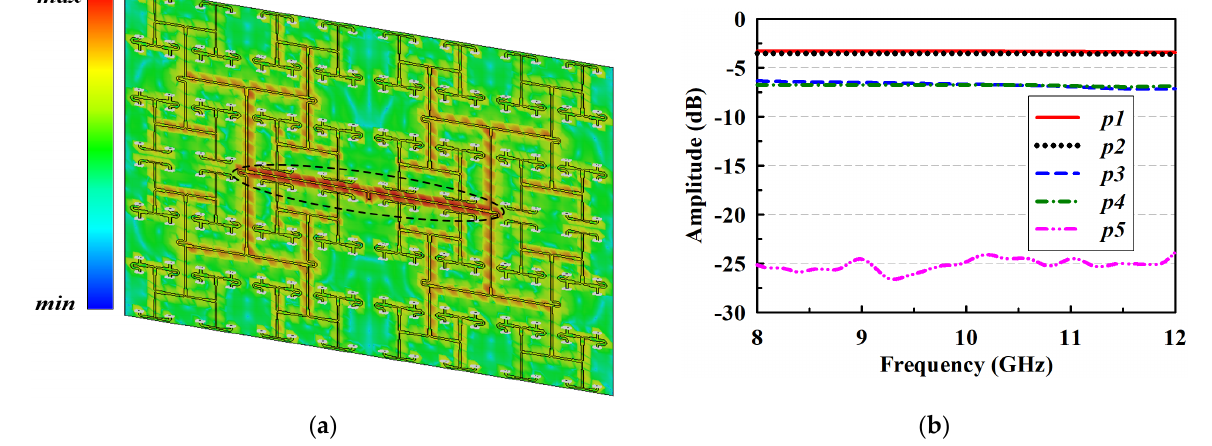
Figure 7. Simulated performance of the developed feeding network; ( a ) current distribution and ( b ) output amplitudes. ( b ) output